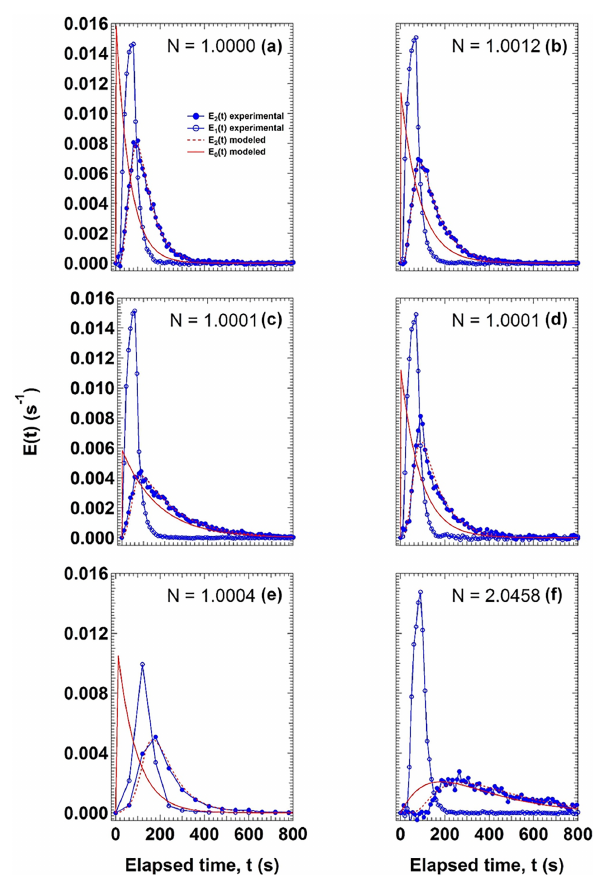
Figure 3. E curves for the WU-PAM configuration I at (a) 52s, (b) 78s, and (c) 156s spacetimes, at 78s spacetimes for (d) config- uration II, (e) configuration III, and (f) for configuration IV at 411s spacetime. Details on the configurations are in the Methods section. Lower-frequency data for panel (e) were due to instrument repair, and temporarily set on longer